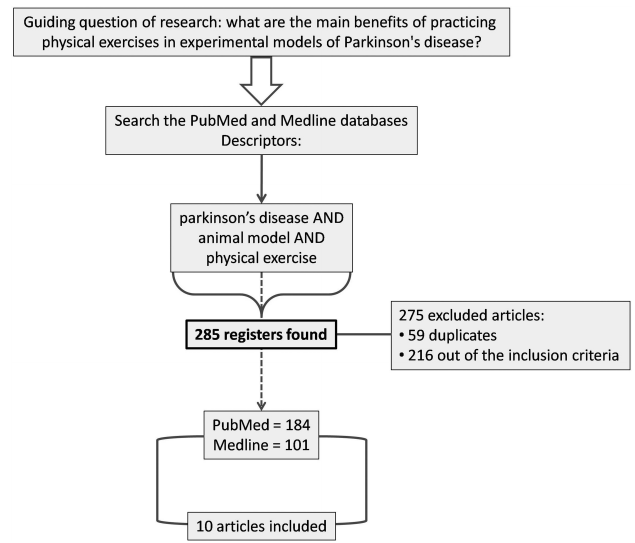
Figure 2. Flow diagram of